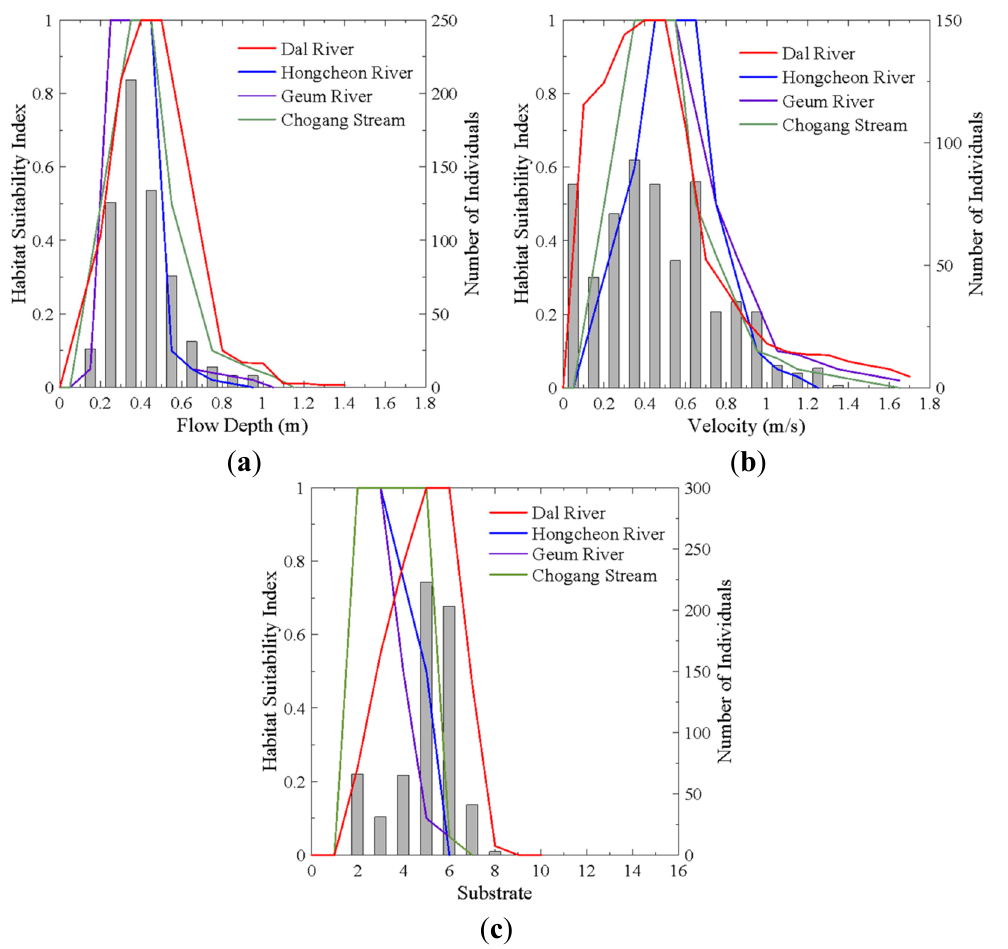
Figure 5. ( a ) Flow depth; ( b ) velocity; ( c ) substrate. Habitat suitability